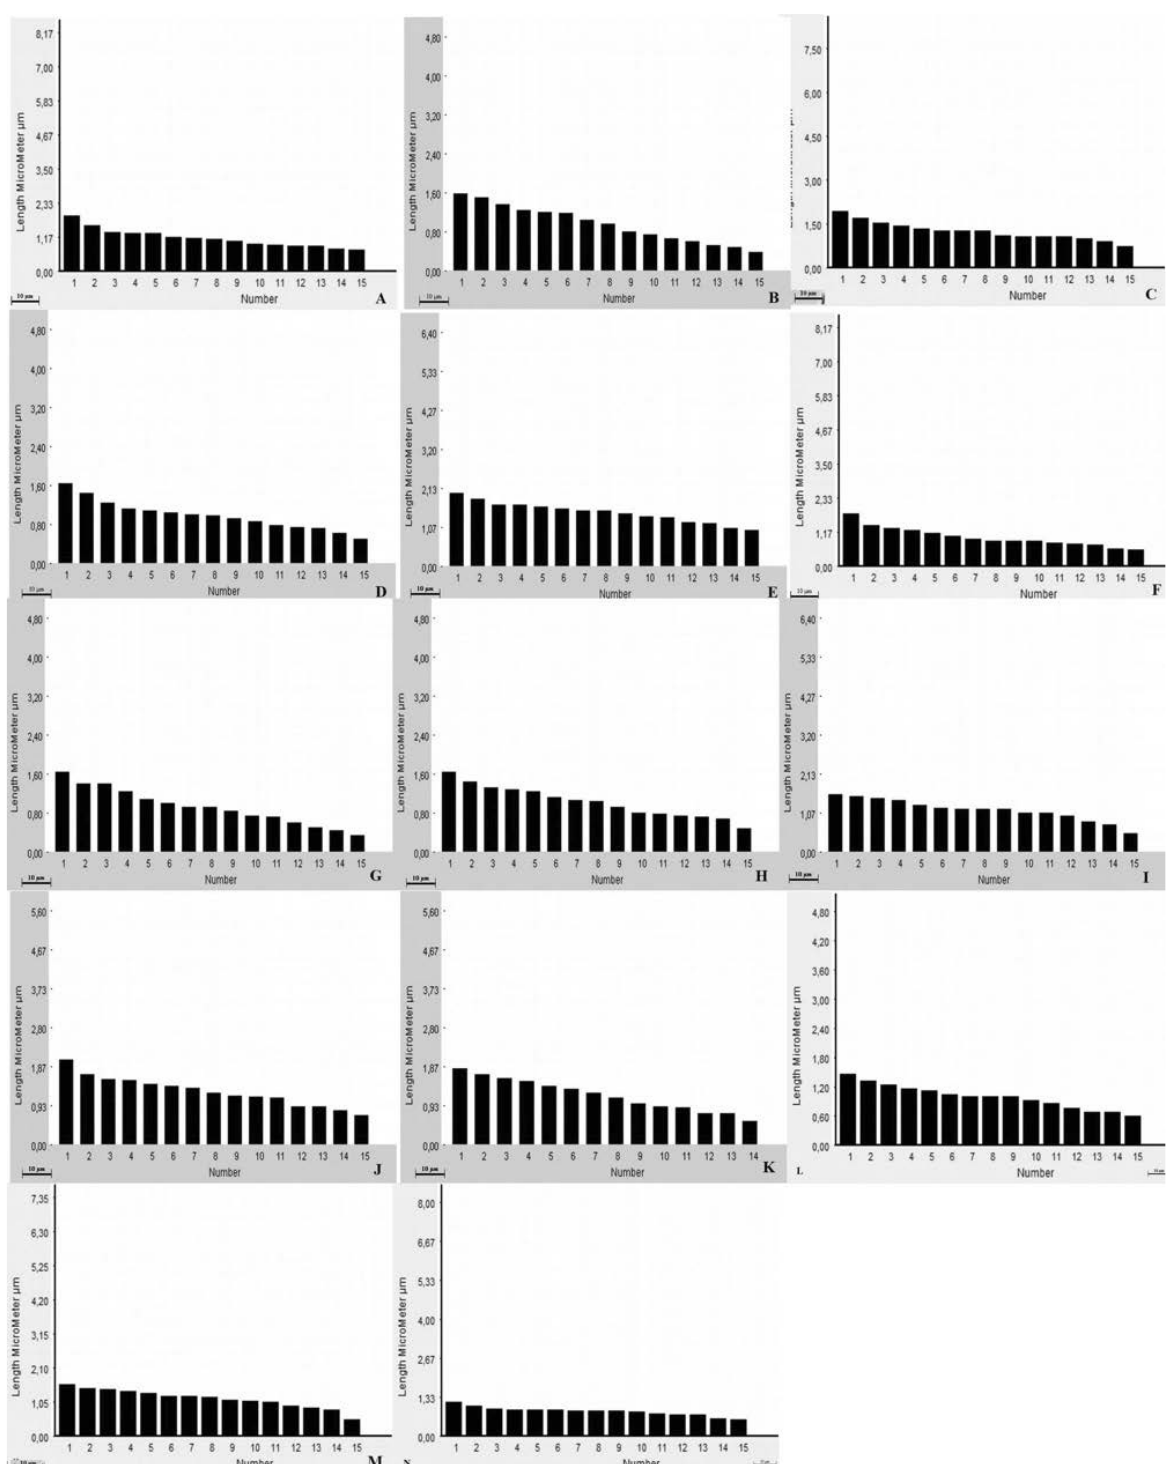
Figure 3A-N. Ideograms of Origanum taxa: A) O . amanum (TD4514a); B) O . bilgeri (TD4343); C) O . boissieri (TD4319); D) O . brevidens (TD4331); E) O . haussknechtii (TA2824); F) O . husnucan - baseri (TD4528); G) O . hypericifolium (TD4357); H) O . leptocladum (TD4345); I) O . majorana (TD3984); J) O . minutiflorum (TD4348); K) O . rotundifolium (TD3943); L) O . saccatum (TD4732); M) O . solymicum (TD4347); N) O . vulgare subsp. vulgare (TD4688). Scale bar: 10